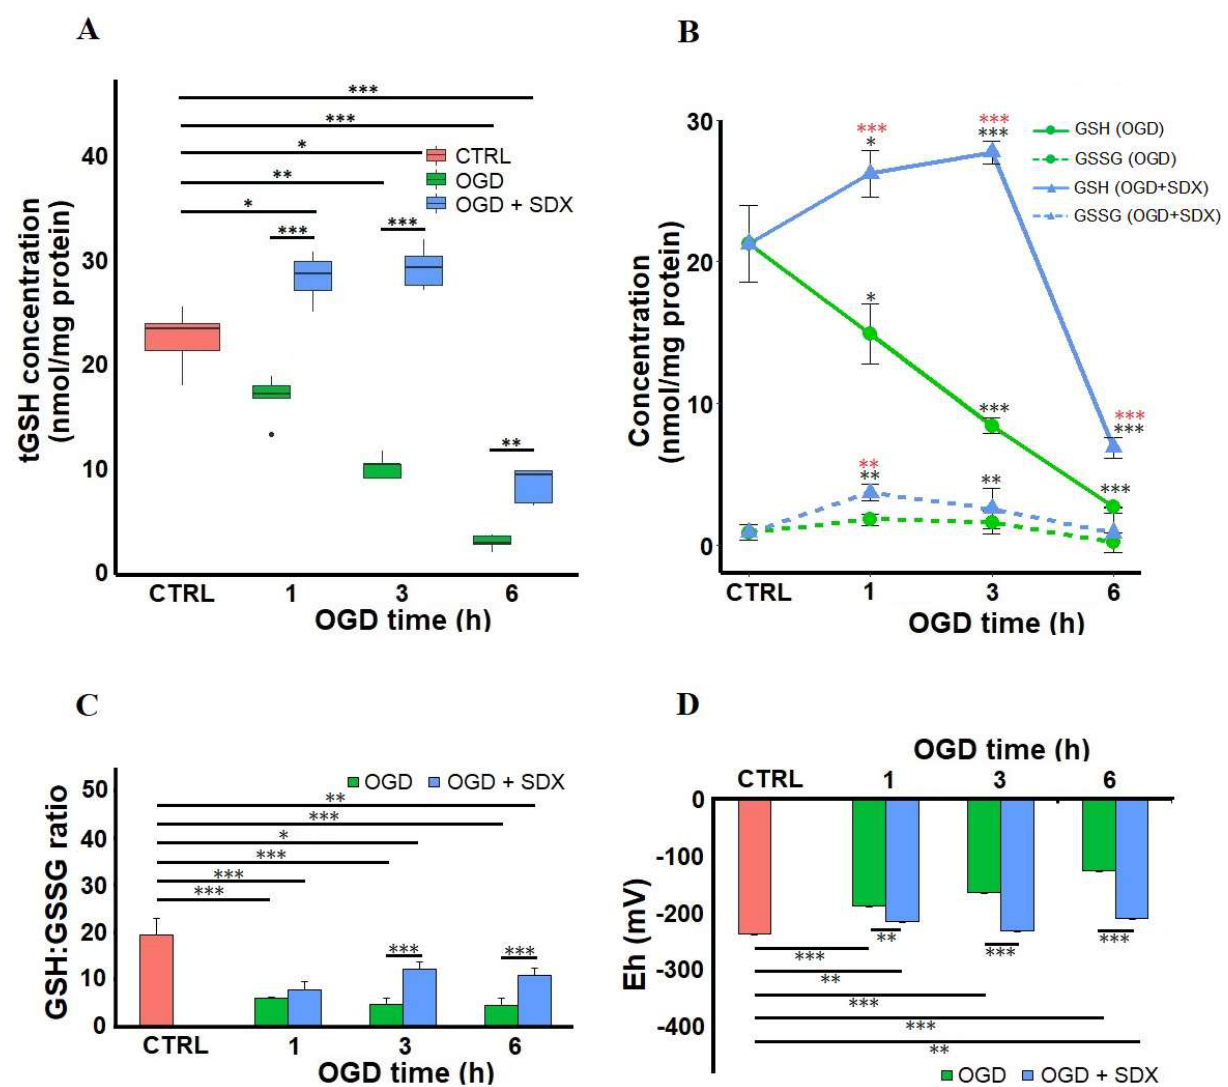
Figure 2. Time-dependent effects of SDX on the intracellular GSH level and redox state in human endothelial cells subjected to OGD. HUVECs were treated for 1, 3, or 6 h in OGD in the absence or presence of SDX (0.5 LRU/mL). The intracellular concentrations of total glutathione (tGSH) ( A ), reduced glutathione (GSH), and oxidized glutathione (GSSG) ( B ) were measured by colorimetric assay ( n = 4–6). The tGSH, GSH, and GSSG levels were normalized to total protein concentrations and expressed as nmol/mg protein. The GSH:GSSH ratio ( C ) and the GSH redox potential (ΔEh) ( D ) for each incubation period were calculated. CTRL: normal conditions; OGD: cells exposed to simulated ischemia in vitro only; OGD + SDX: cells exposed to simulated ischemia in vitro and treated with SDX. Data in panel ( A ) are box-plots representing the median and quartiles with the upper and lower limits. Each point in panel ( B ) and bar graphs in panels ( C , D ) represent mean ± standard deviation (SD). In panels ( A – D ), the asterisks indicate the statistically significant differences (* p < 0.05; ** p < 0.01; *** p < 0.001). In panel B, statistically significant differences between OGD groups and OGD + SDX groups are marked with red asterisks (*), while black asterisks (*) are used to mark the differences between the test groups and Control group. [·] is the oulier.